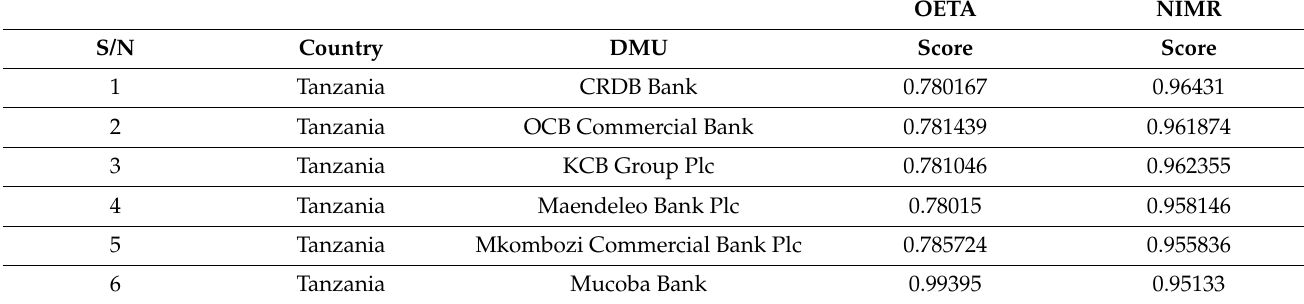
Table A1. DEA Efficiency